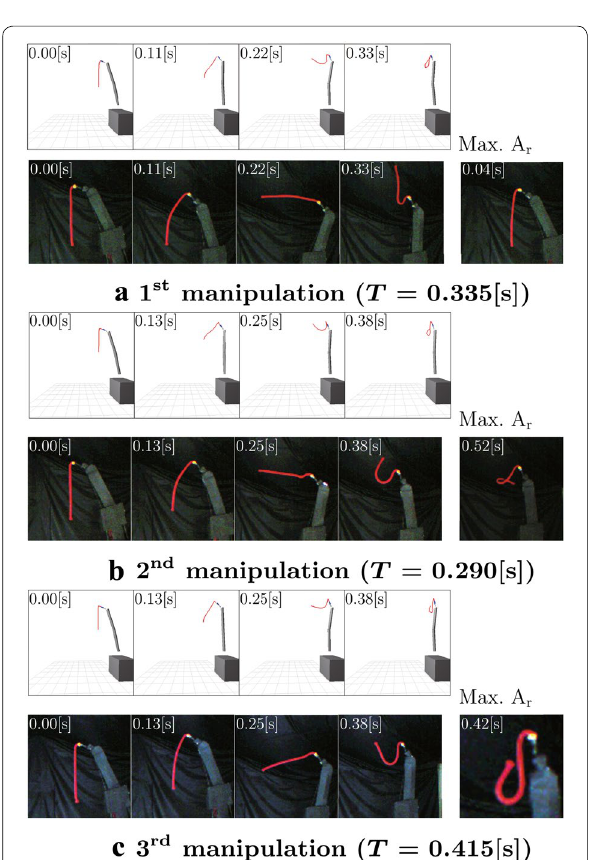
Fig. 10 Change of generated motion and actual string motion (Desired image of string shape: d